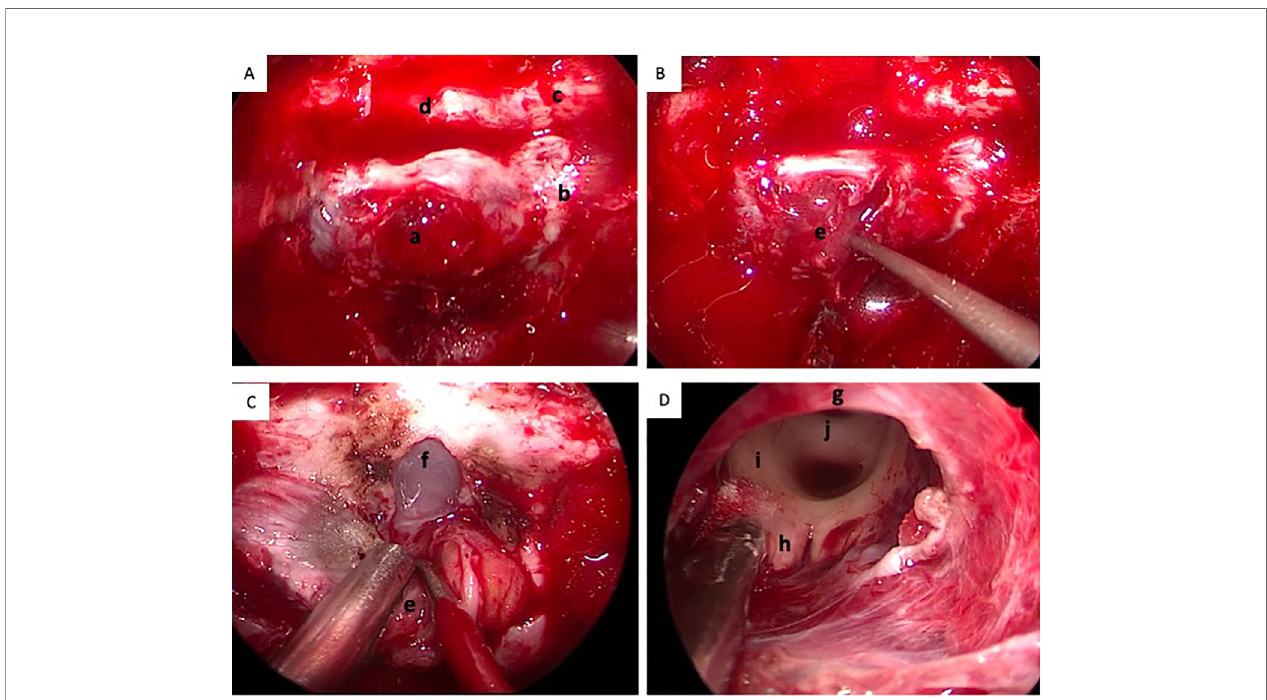
FIGURE 2 | Intra-operative conditions of the lesion. (A) The dura of sellar fl oor was invaded by the tumor; (B) The lesion was soft, mimicking pituitary adenoma in texture (the arrow); (C) The dura of sphenoid platform was opened; (D) The lesion was totally resected and the third ventricle was revealed. a, the invaded dura of the sellar fl oor; b, the cavernous sinus; c, the optic nerve; d, the sphenoid platform; e, the tumor; f, the arachnoid membrane of sphenoid platform; g, the optic chiasm; h, the mamillary body; i, posterior